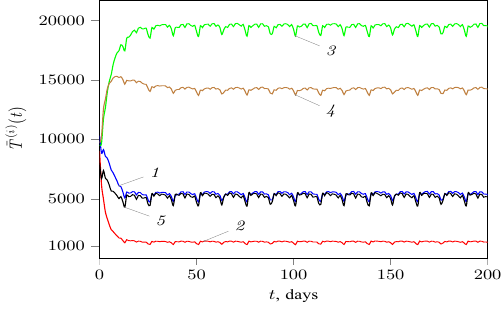
1 Figure 3. Dynamics of point estimates T ( i ) ( t ) without HIV-1 infection at experiment 1.